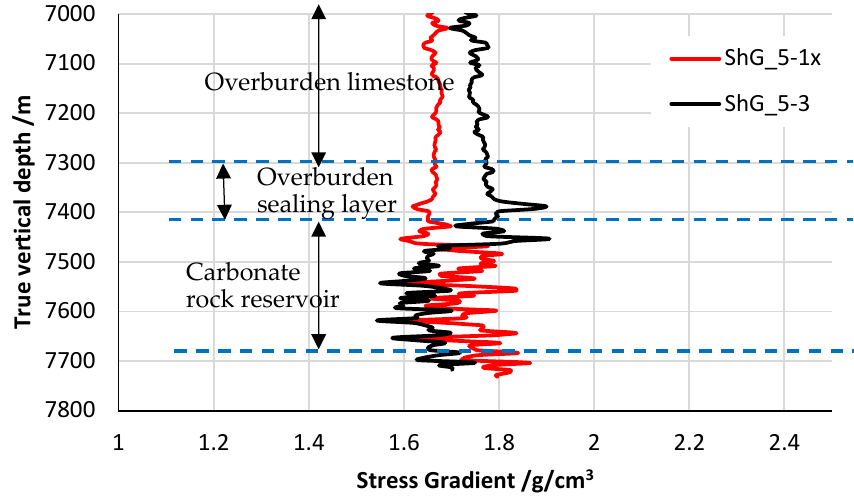
Figure 10. Distribution of minimum horizontal stress gradient ShG at locations of 2 wells.